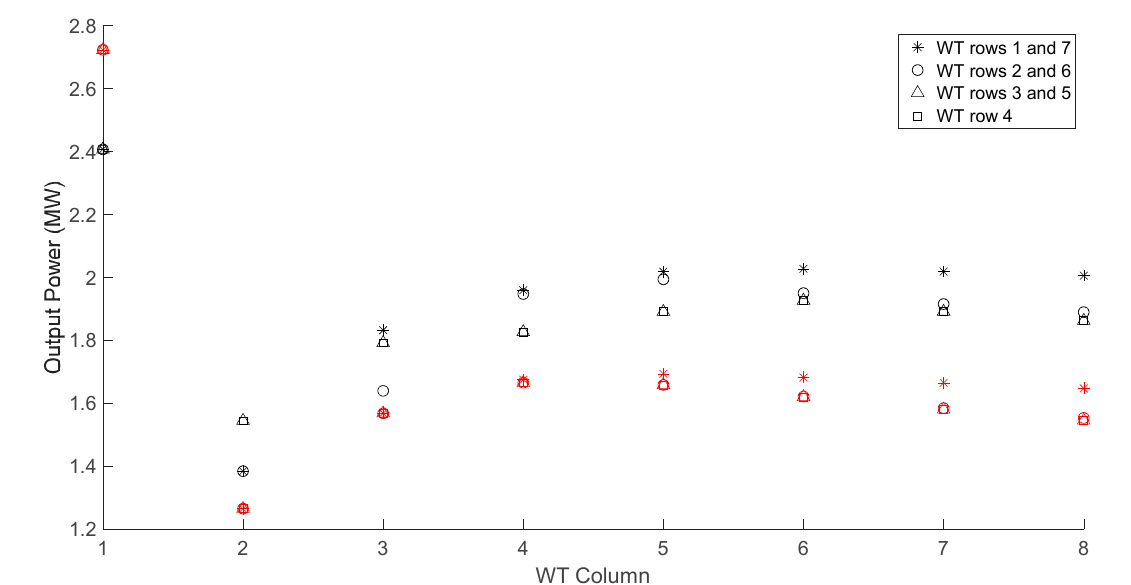
Figure 6. Power generated by each wind turbine by means of the classic pitching strategy (markers in red) and the optimized pitching strategy proposed in this work (markers in black).